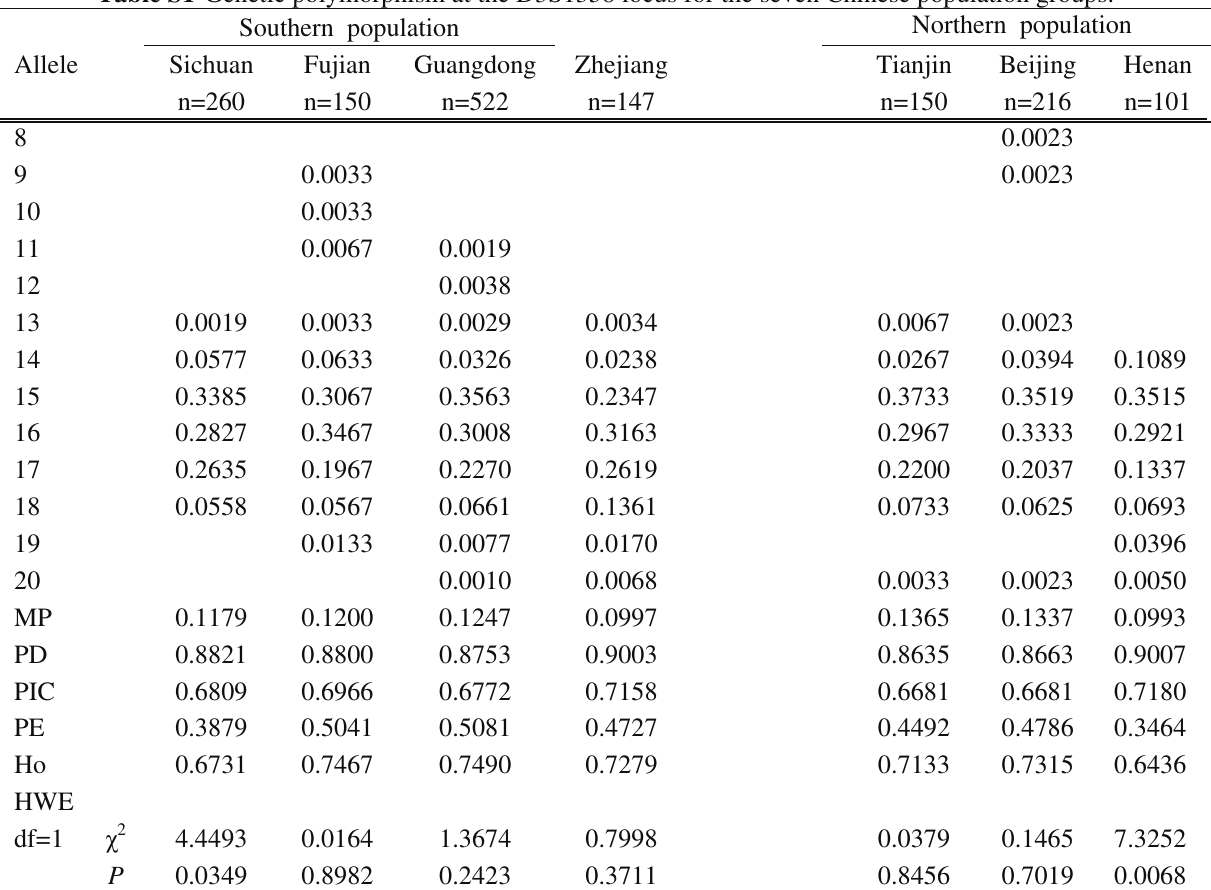
Table S1- Genetic polymorphism at the D3S1358 locus for the seven Chinese population